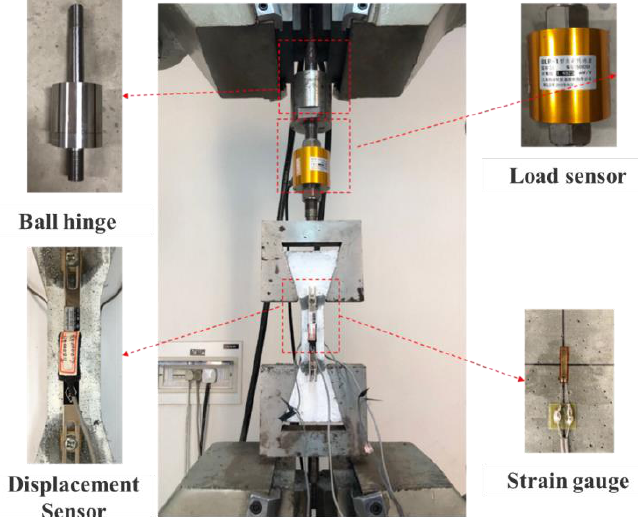
Figure 4 . Tensile test